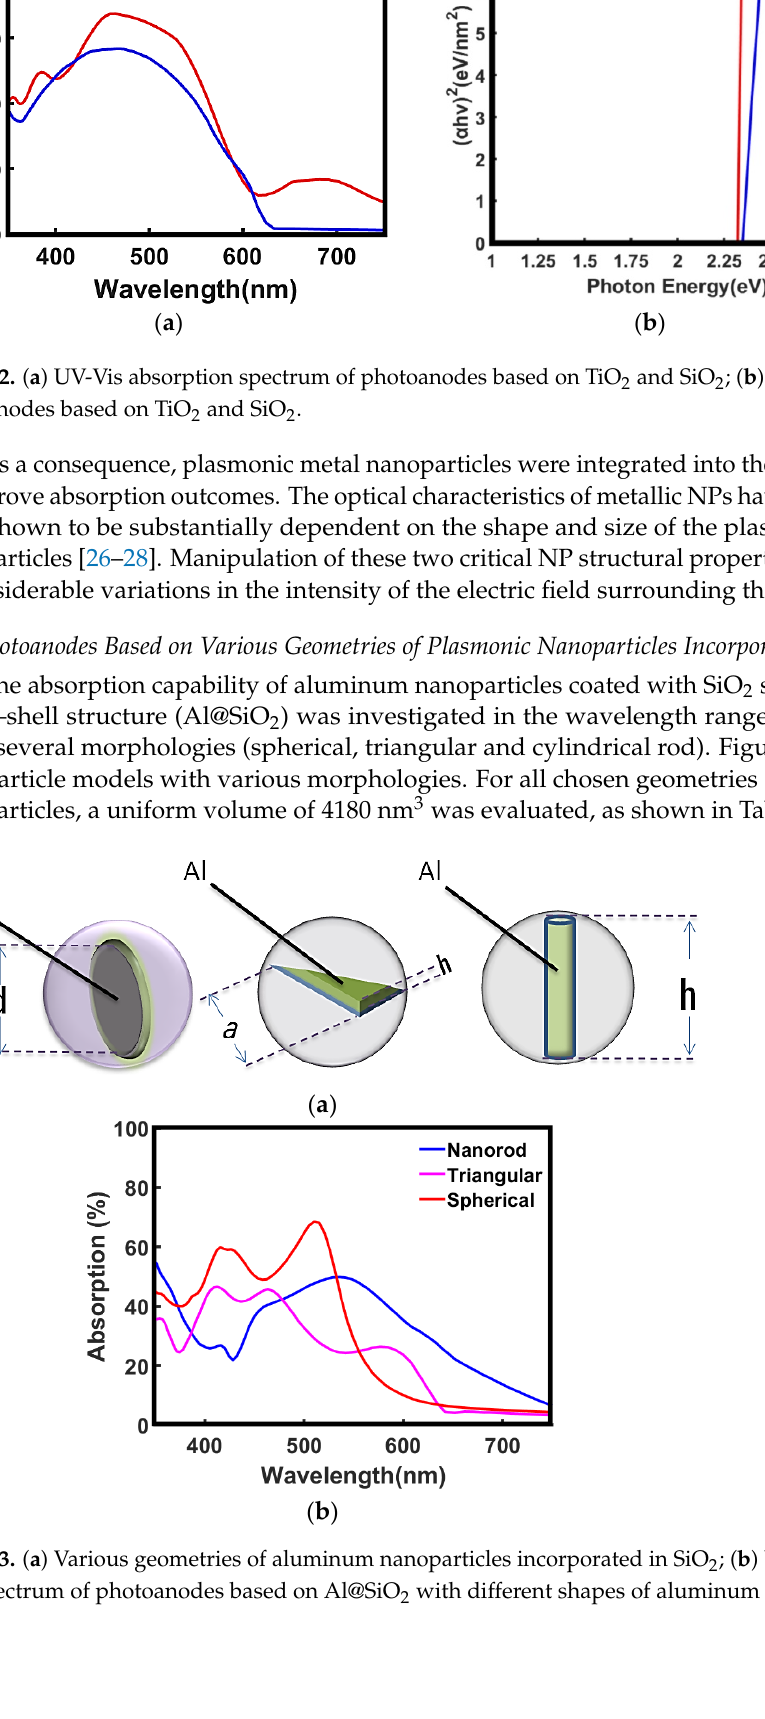
Figure 3. ( a ) Various geometries of aluminum nanoparticles incorporated in SiO 2 ; ( b ) UV-Vis absorption spectrum of photoanodes based on Al@SiO 2 with different shapes of aluminum nanoparticles.